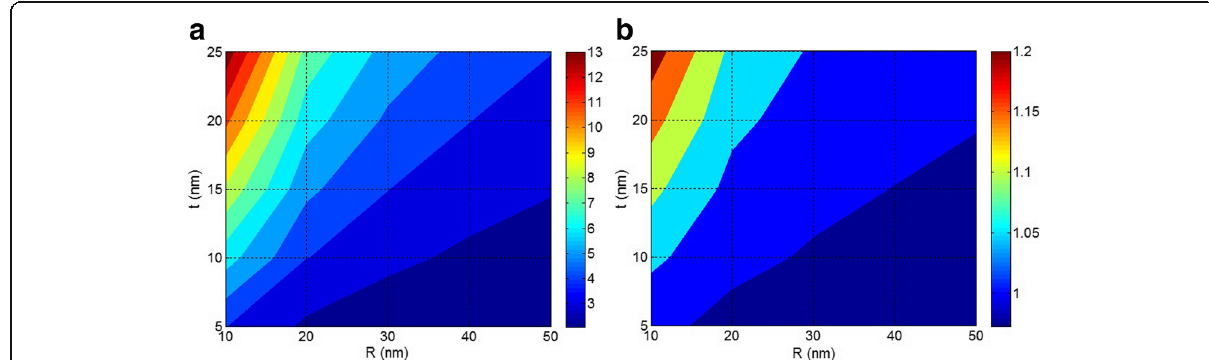
Fig. 4 a B interfacial parameter and b relative tensile strength by Pukanszky model at different ranges of R and d f and constant σ i / σ m =5 and ϕ f